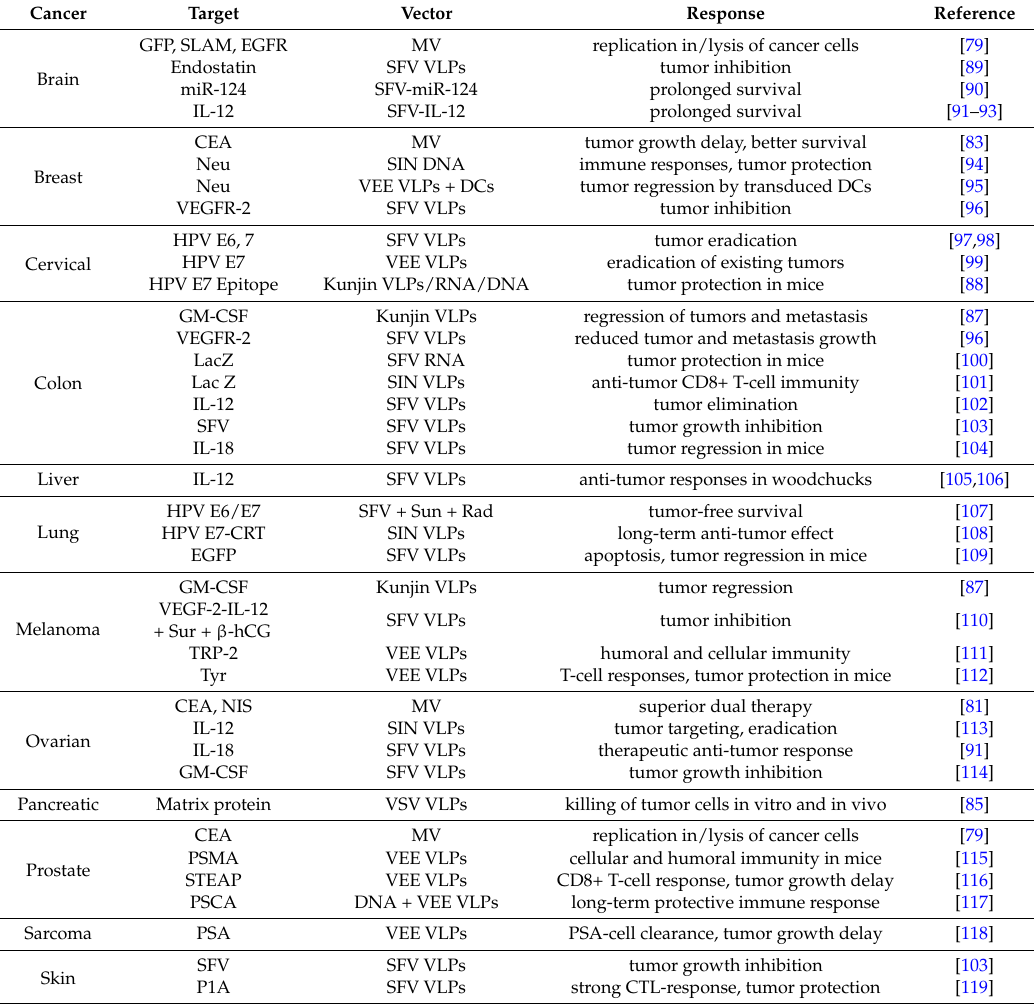
Table 3. Self-Replicating RNA Viral Vector-Based Immunizations against